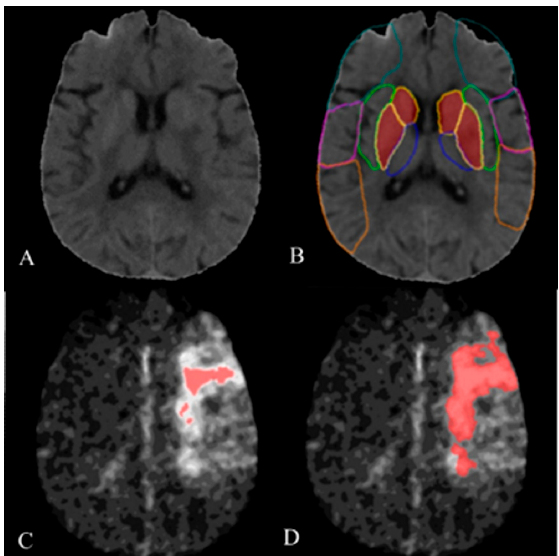
Figure 4. The schematic diagrams of the calculation of e-ASPECT and HI using NSK software; ABCD are obtained from the same patient with a left middle cerebral artery occlusion. ( A ) NCCT; ( B ) ASPECT is measured using NSK software (e-ASPECT), and the calculated score is 8; ( C ) the volume of Tmax > 10 s (marked red), and the calculated volume is 6.46 mL; ( D ) the volume of Tmax > 6 s (marked red), and the calculated volume is 48.40 mL. The HI of this patient is 0.13.